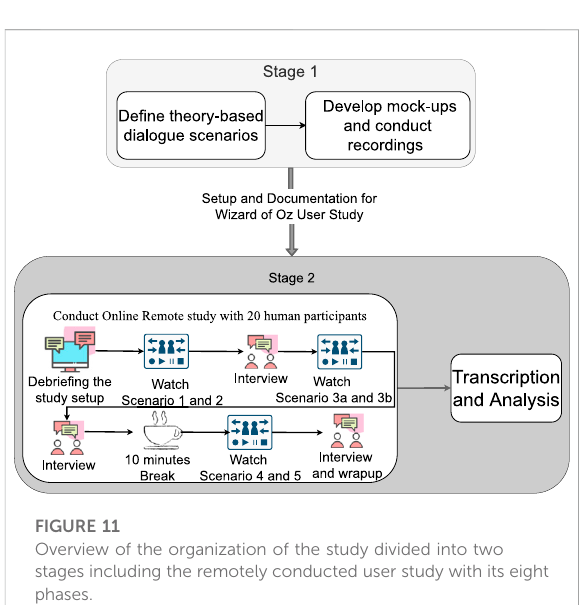
FIGURE 11 Overview of the organization of the study divided into two stages including the remotely conducted user study with its eight